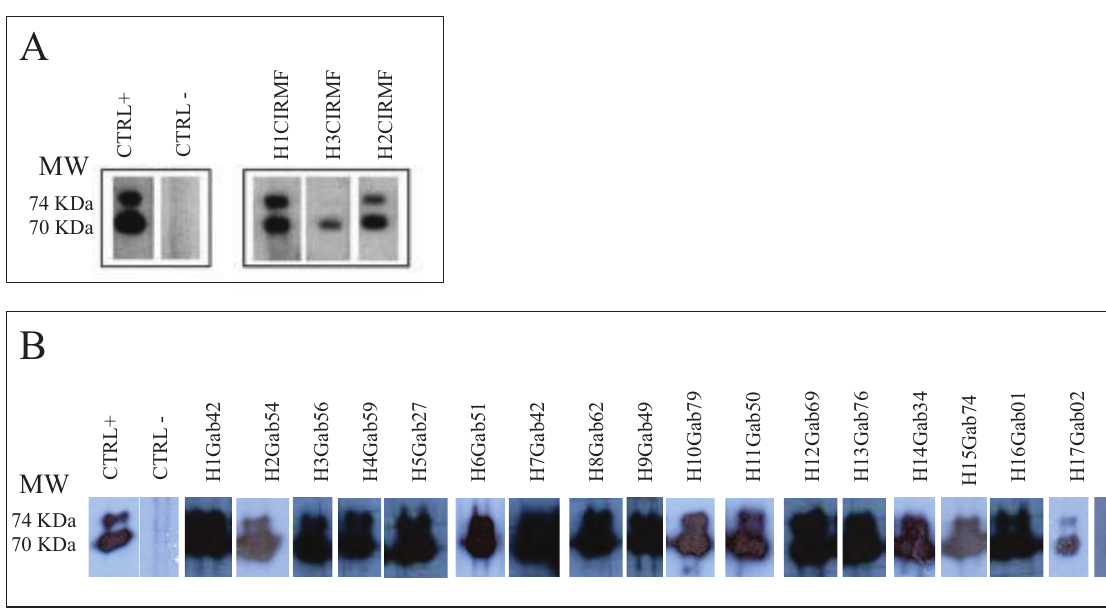
Figure 7. SFV-specific antibodies detected by western blot in plasma samples obtained from humans bitten by non-human primates in Gabon. Seropositivity was defined by the presence of reactivity to the Gag doublet of 70 kDa and 74 kDa as shown for positive controls (CTRL+); seronegativity was defined as no bands of the Gag doublet observed by western blot, as in the negative control (CTRL – ). Reactivity with a single band in the 70- to 74-kDa molecular mass range was considered indeterminate. ( A ) Western blot pattern of the three people bitten by non-human primates at the CIRMF; ( B ) western blot pattern of individuals bitten by wild non-human primates in various regions of rural